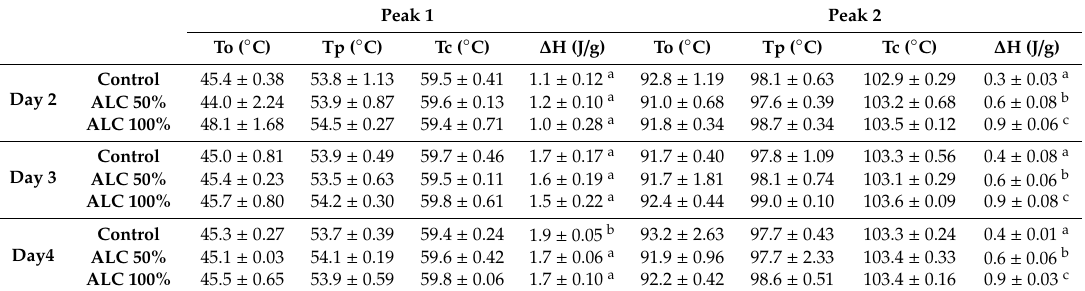
Table 6. Thermal properties of amylose-lipid-containing bread during storage at room